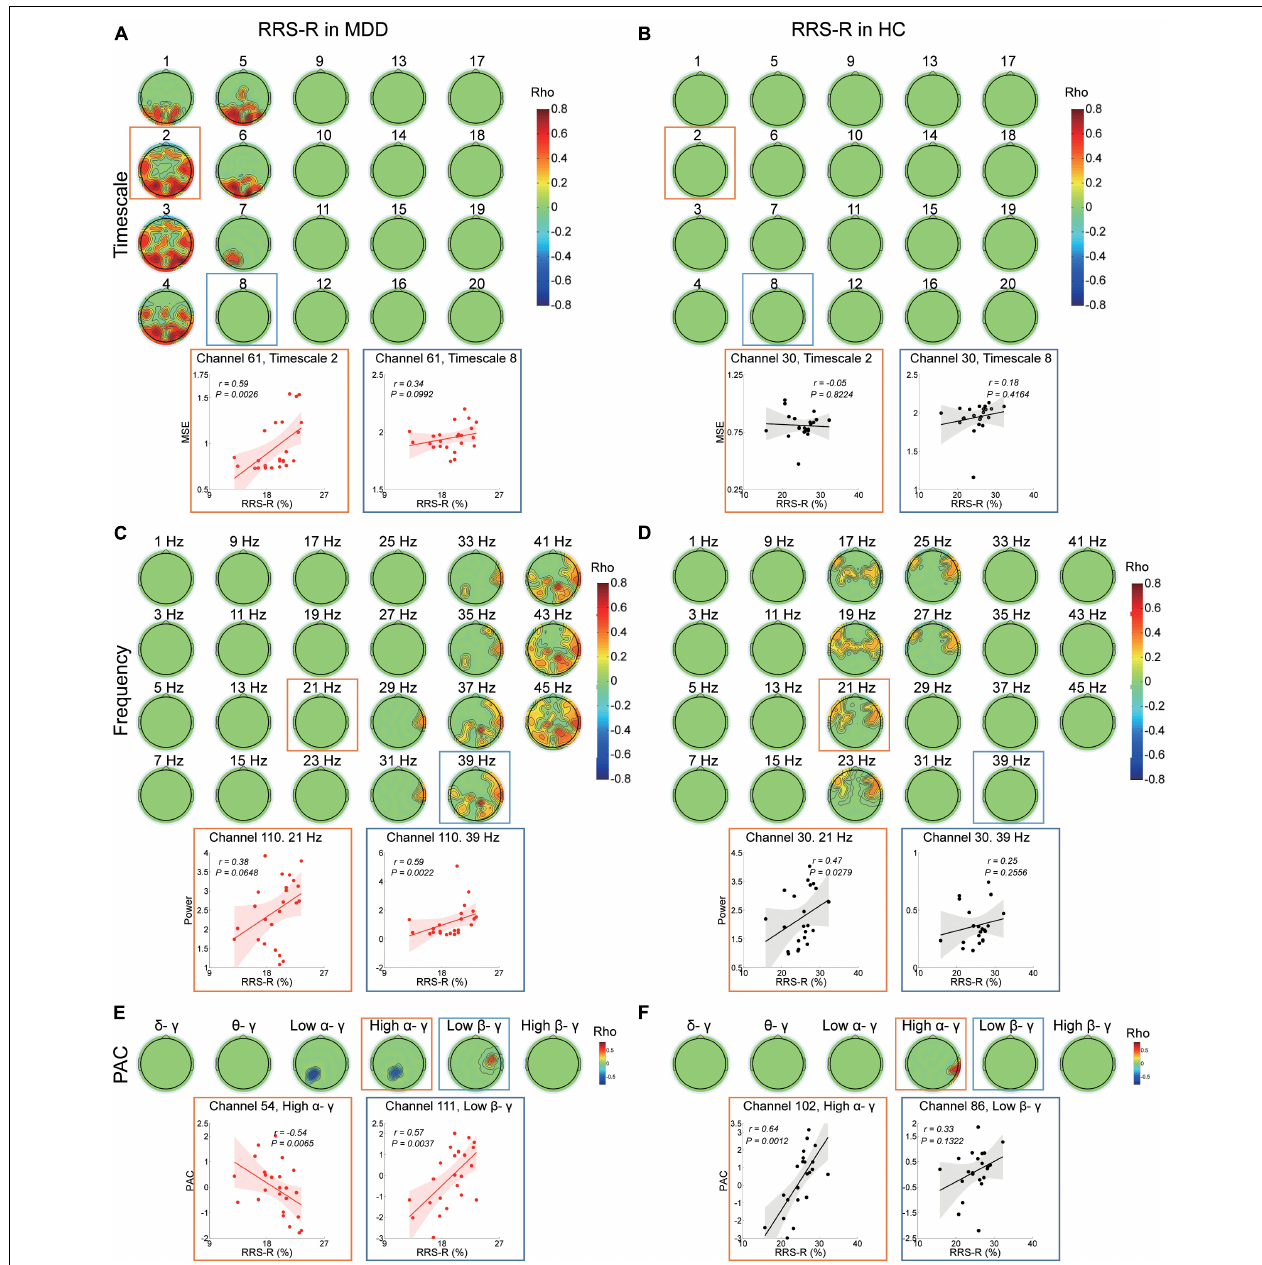
FIGURE 2 | Association between EEG dynamics and adaptive rumination in the MDD and HC groups. (A) Top: Topographies illustrate the significant (positive cluster P = 0.008, cluster-based corrected) correlation between RRS-R scores and MSE in the MDD group. Bottom: Scatter plots show examples in the parietal region at fine (channel 61, timescale 2, r = 0.59, P = 0.003) and coarser (channel 61, timescale 8, r = 0.34, P = 0.1) timescales. (B) Top: Topographies illustrate no significant (cluster P > 0.05) correlation between the RRS-R scores and MSE in the HC group. Bottom: Scatter plots show examples in the central region at fine (channel 30, timescale 2, r = –0.05, P = 0.822) and coarser timescales (channel 30, timescale 8, r = 0.18, P = 0.416). (C) Top: Topographies illustrate the significant (positive clusters P = 0.018, cluster-based corrected) correlation between RRS-R scores and EEG power (presented with a step of 2 Hz) in the MDD group. Bottom: Scatter plots show examples in the central region in the beta (channel 110, 21 Hz, r = 0.38, P = 0.065) and gamma (channel 110, 39 Hz, r = 0.59, P = 0.002) bands. (D) Top: Topographies illustrate the significant (positive cluster P = 0.0492, cluster-based corrected) correlation between RRS-R scores and EEG power (presented with a step of 2 Hz) in the HC group. Bottom: Scatter plots show examples in the central region in the beta (channel 30, 21 Hz, r = 0.47, P = 0.028) and gamma (channel 30, 39 Hz, r = 0.25, P = 0.256) bands. (E) Top: Topographies illustrate the significant correlation between the PAC and RRS-R scores in the MDD group (negative cluster P low α / γ = 0.016, negative cluster P high α / γ = 0.029, positive cluster P low β / γ = 0.042). Bottom: Scatter plots show examples of high alpha/gamma PAC in the parietal region (channel 54, r = –0.54, P = 0.007) and low beta/gamma PAC in the central region (channel 111, r = 0.57, P = 0.004). (F) Top: Topographies illustrate the significant correlation between PAC and the RRS-R scores in the HC group (positive cluster P high α / γ = 0.037). Bottom: Scatter plots show examples of high alpha/gamma in the parietal region (channel 102, r = 0.64, P = 0.001) and low beta/gamma in the parietal region (channel 86, r = 0.33, P = 0.132) PAC.